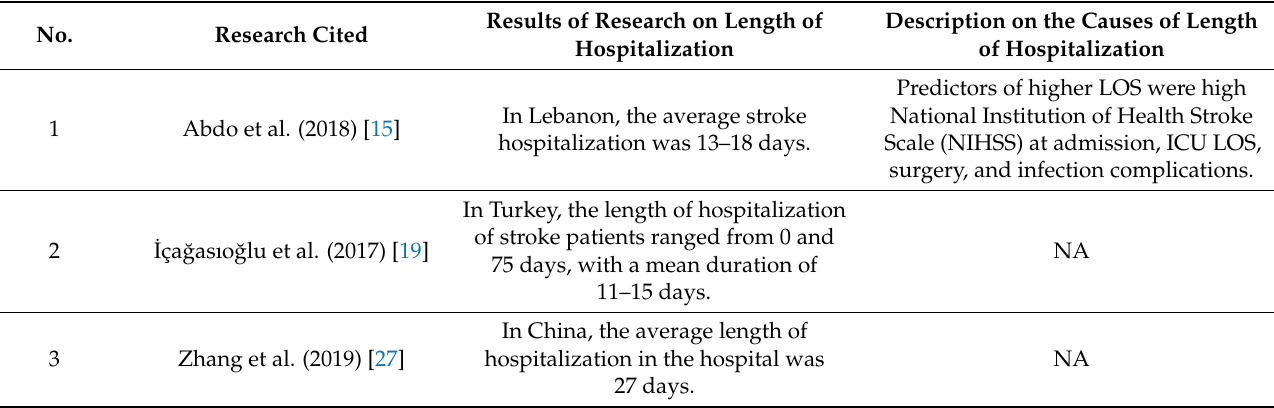
Table 2. Descriptions of length of hospitalization for stroke